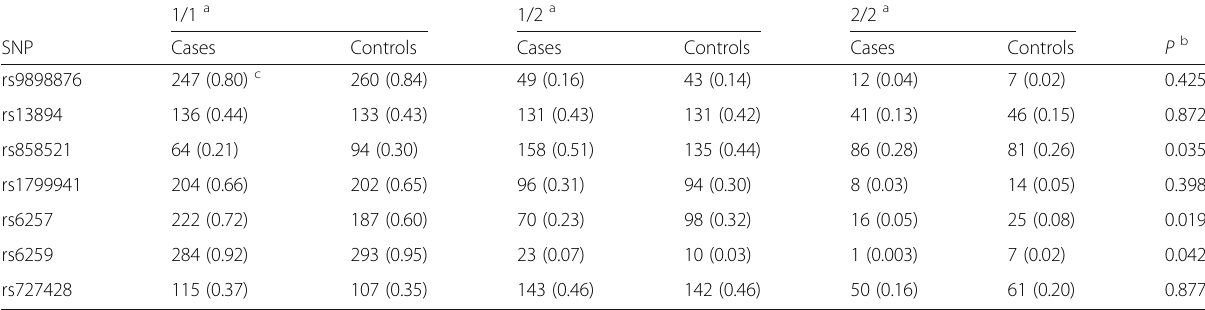
Table 3 SHBG Genotype